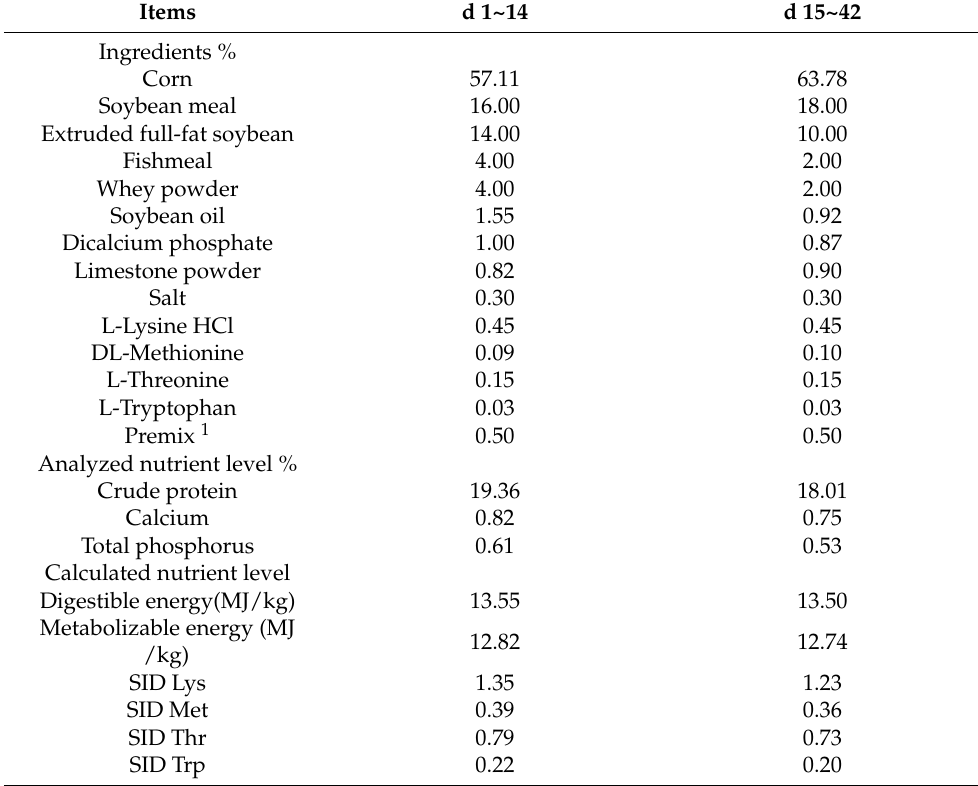
Table 1. Composition and nutrient levels of the basal diet (%, as-fed